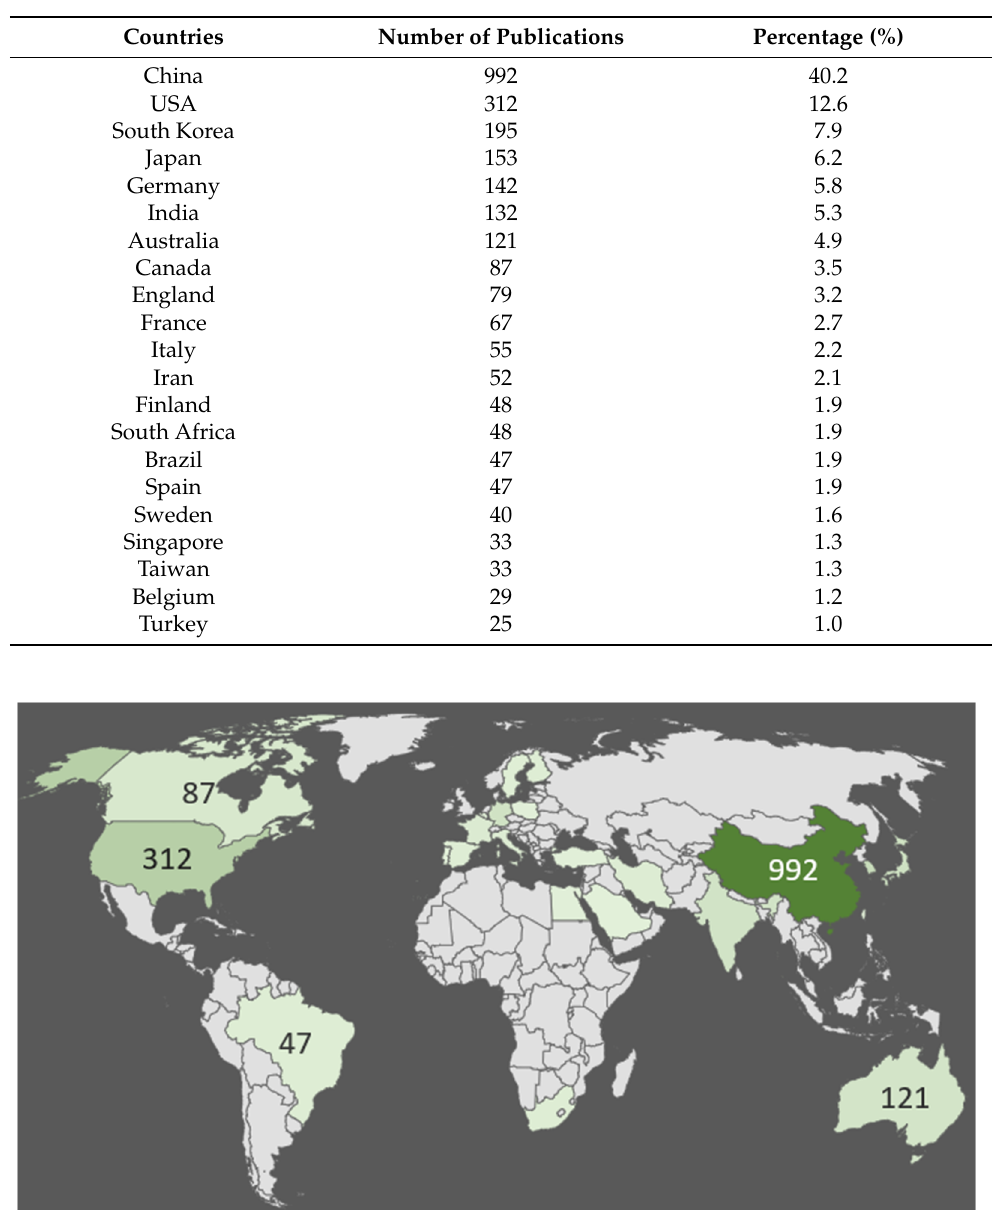
Table 1. Countries with at least 1% publication on LIB recycling.